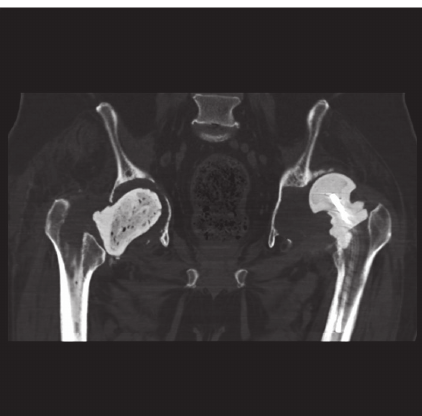
Figure 2: 3D CT reconstruction showing a dislocated left-sided THR secondary to a posterior acetabular wall